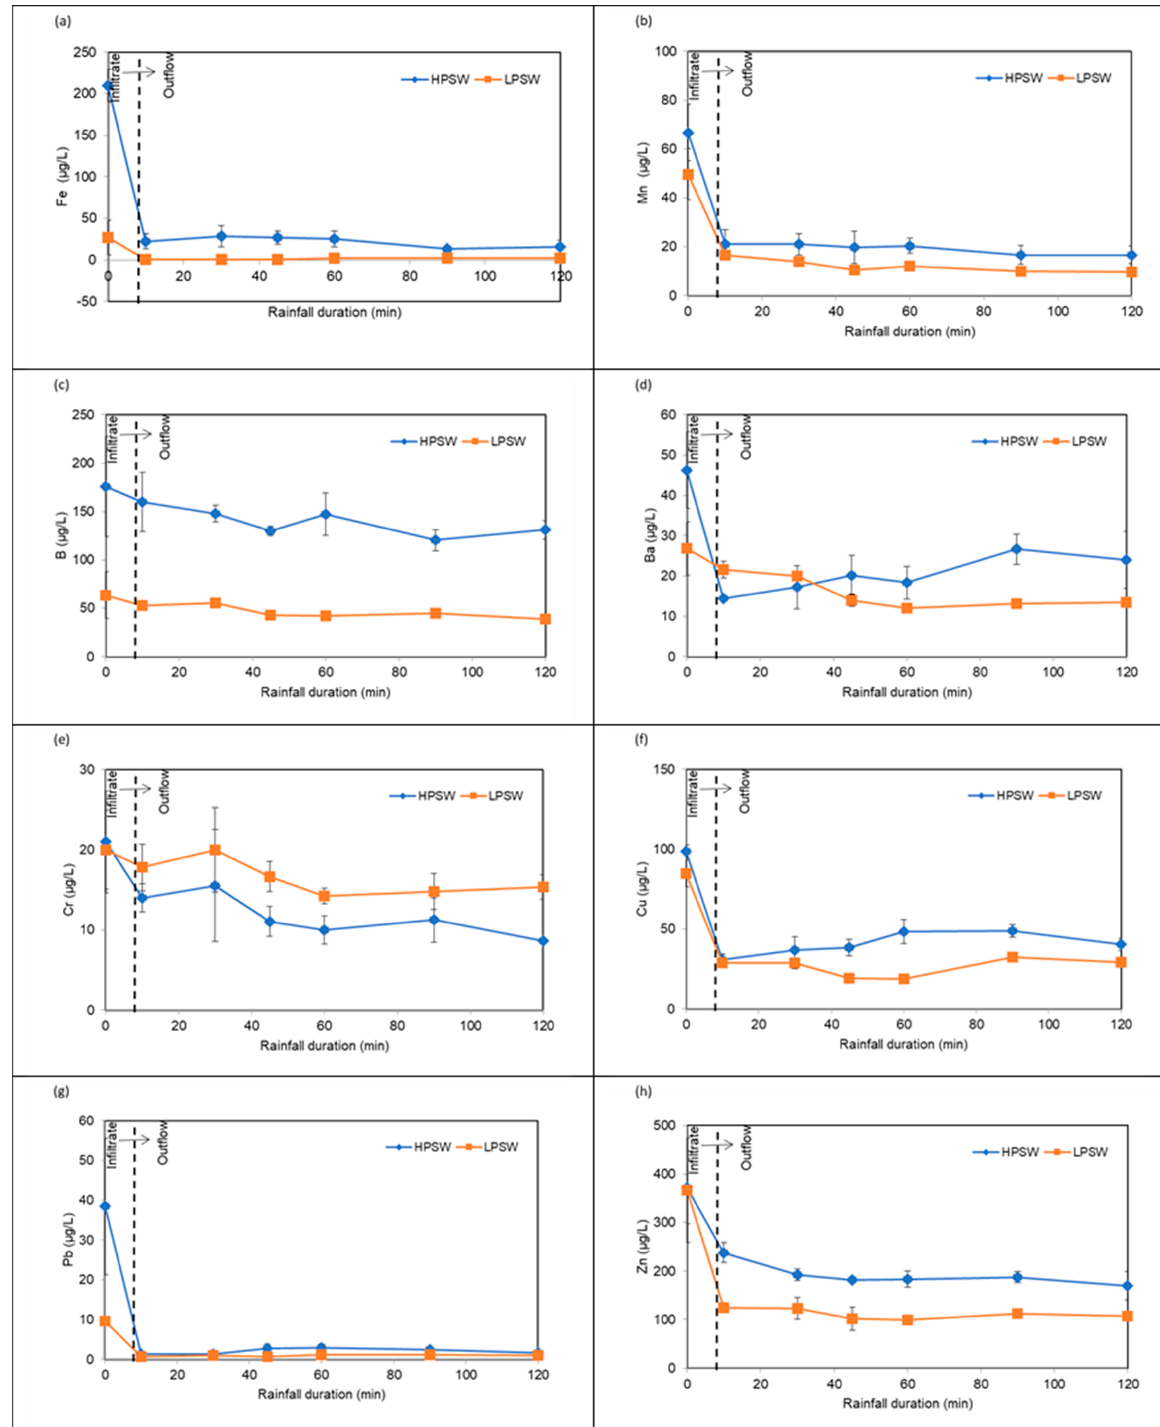
Figure 8. Variations of ( a ) Fe, ( b ) Mn, ( c ) B, ( d ) Ba, ( e ) Cr, ( f ) Cu, ( g ) Pb and ( h ) Zn before and after infiltration through permeable clay